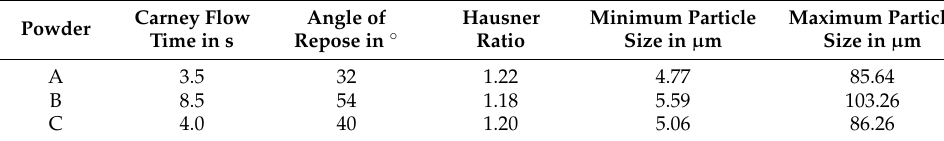
Table 4. Characteristic powder properties of the used starting powders.